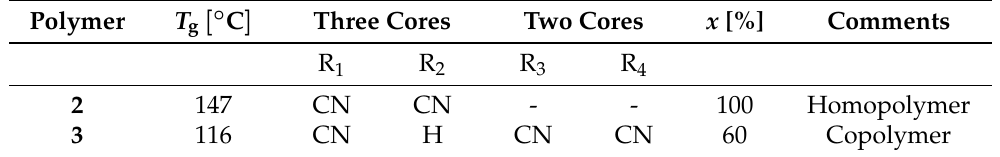
Figure 3. ( a ) Structural formula of PMMA-based side-chain azo polymers used in this work. x denotes the relative percentage of each side-chain. ( b ) Absorption spectra of used polymers. The wavelengths for excitation and analysis are labelled. Table 1. Functional groups of the given side-chain azo (co-)polymers used in this work. Glass transition temperatures T g and the relative percentage of each side-chain are